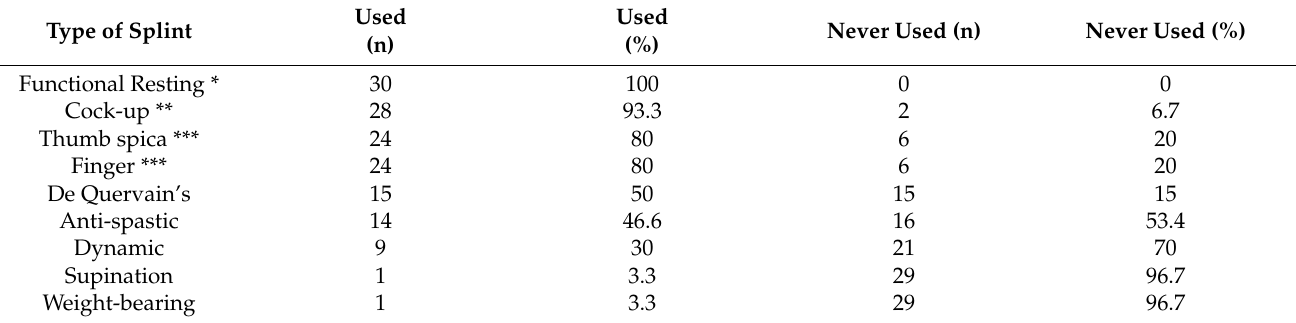
Table 3. Service frequency of various splint types ( n = 30).